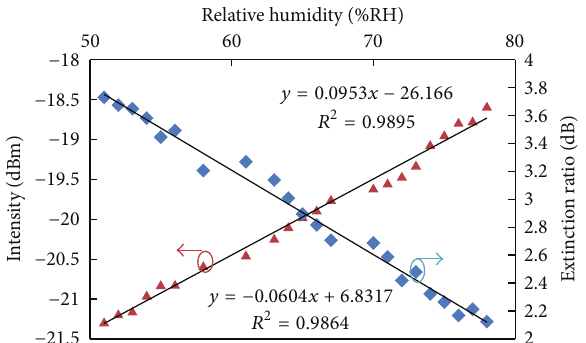
Figure 6: Relationship between RH and extinction ratio/intensity of resonant wavelength 𝐴